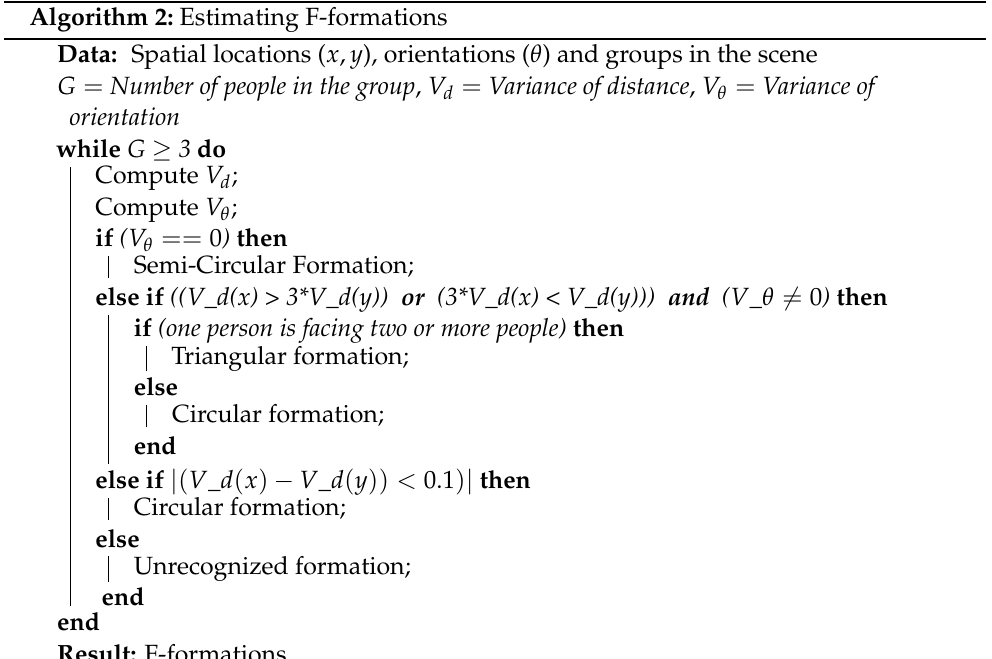
Algorithm 2: Estimating